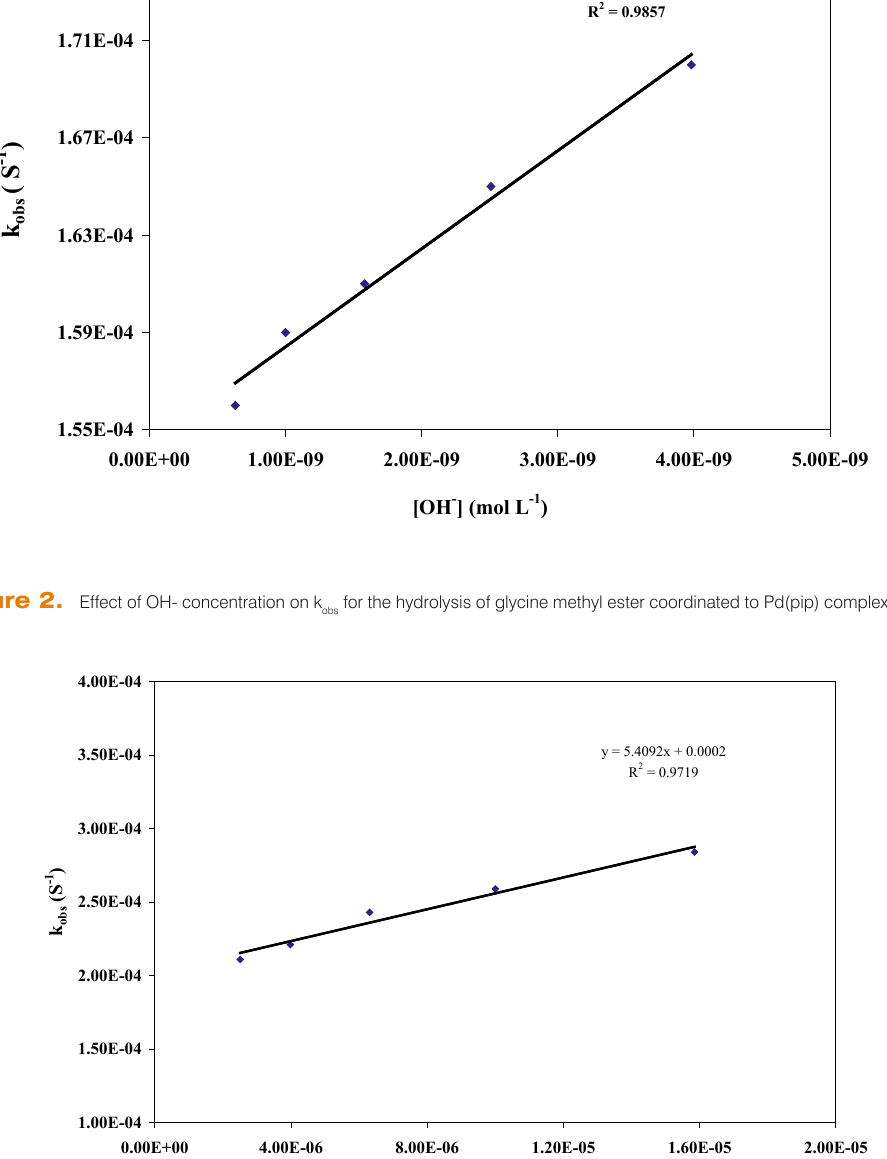
Figure 3. Effect of OH- concentration on kobs for the hydrolysis of methionine methyl ester coordinated to Pd(pip) complex at